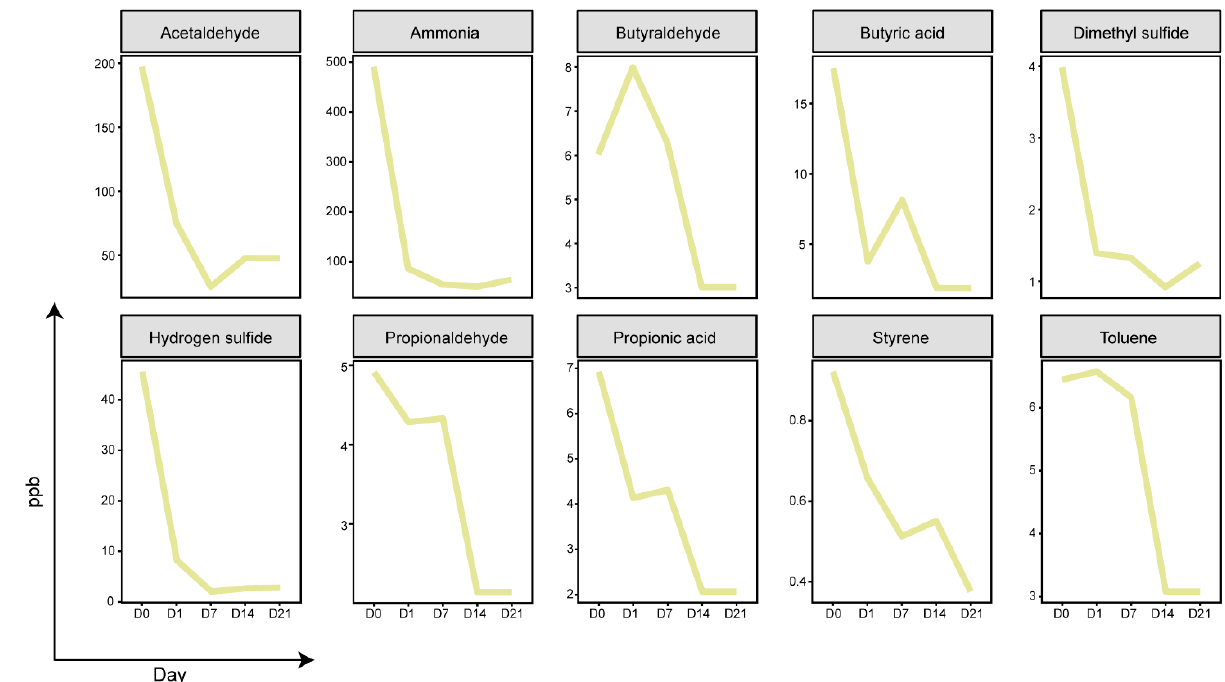
Figure 2. Reduction of odorous chemicals after fermented coffee ground (FCG) treatment. The concentrations of odorous chemicals are measured in parts per billion (ppb), and the representing points are before FCG treatment (“manure”) and days 1, 7, 14, and 21 after treatment.